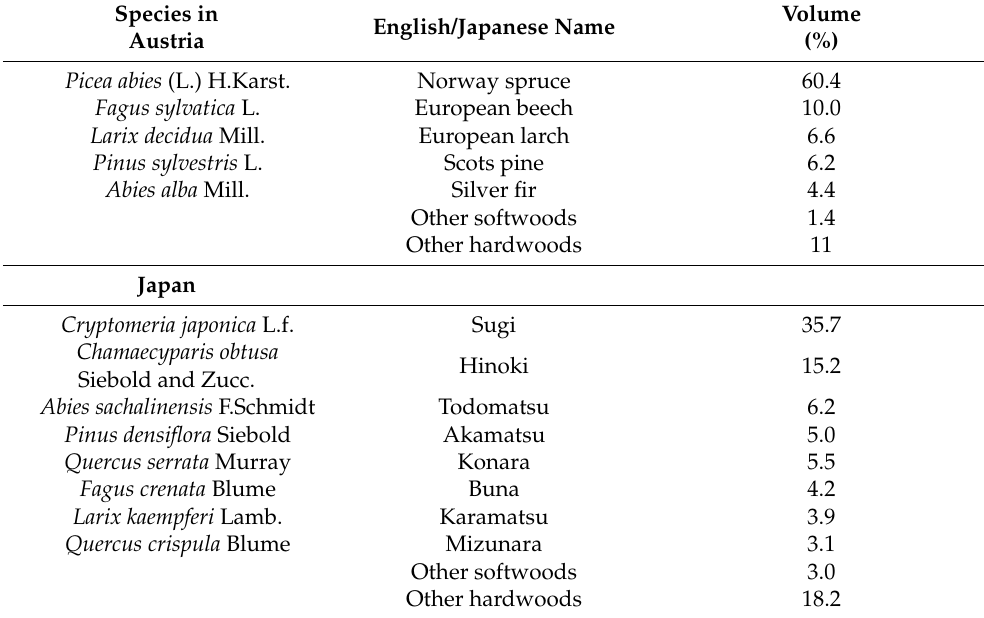
Table 1. Tree species and their respective percentage of the total national standing volume. Data are from the Austrian National Forest Inventory (2018) and Japanese National Forest Inventory (2013). Species in Volume English/Japanese Name Austria (%) Picea abies (L.) H.Karst. Norway spruce 60.4 Fagus sylvatica L. European beech Larix decidua Mill. Pinus sylvestris